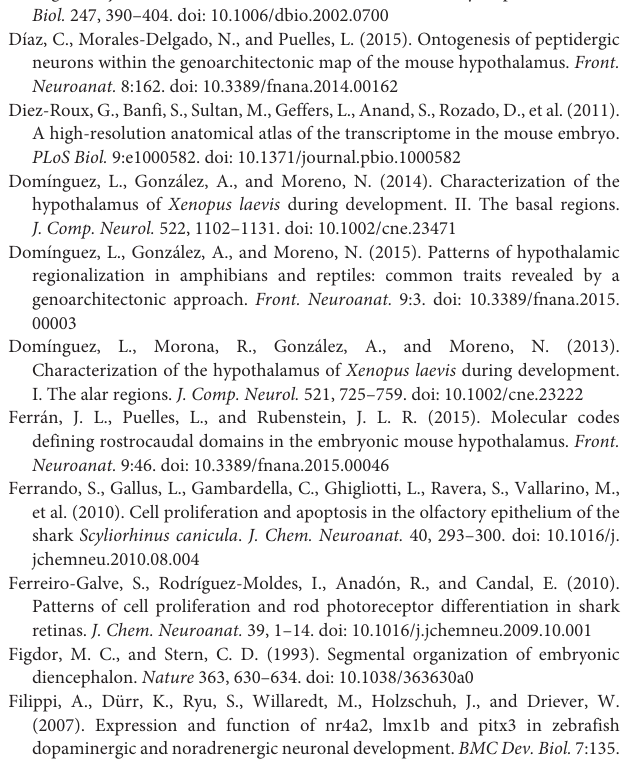
Figdor, M. C., and Stern, C. D. (1993). Segmental organization of embryonic diencephalon. Nature 363, 630–634. doi: